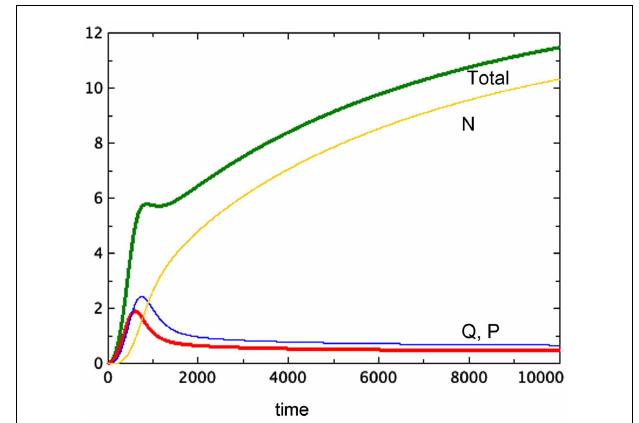
FIGURE 2 |A typical run of Model 3E. a = 0.01, b P,Q = 0.01, c Q,P = 0.005, d = 0.002, e Q,N = 0.002, f = 0.01, h = 0, m = 0.0001, P 0 = 0.01, Q 0 = 0, N 0 =